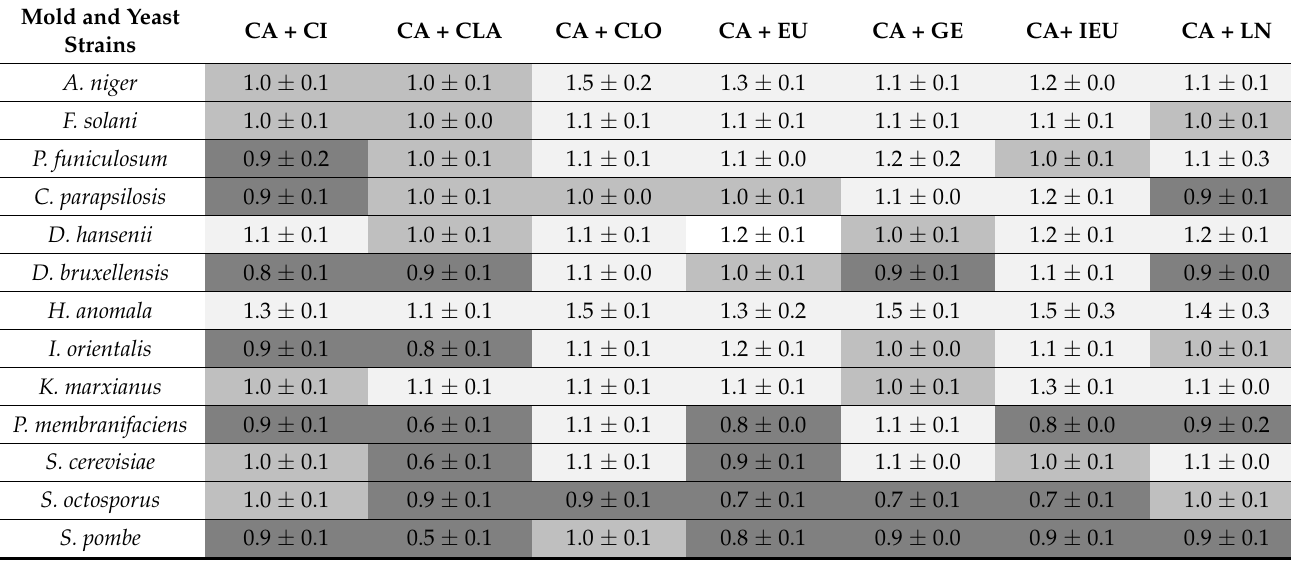
Table 2. FIC indices (dark grey = synergistic; medium grey = commutative; light grey = indifferent) of cinnamaldehyde (CA) in combination with selected EOCs as means ± standard error of independent biological triplicate measurements ( n = 3). Mold and Yeast